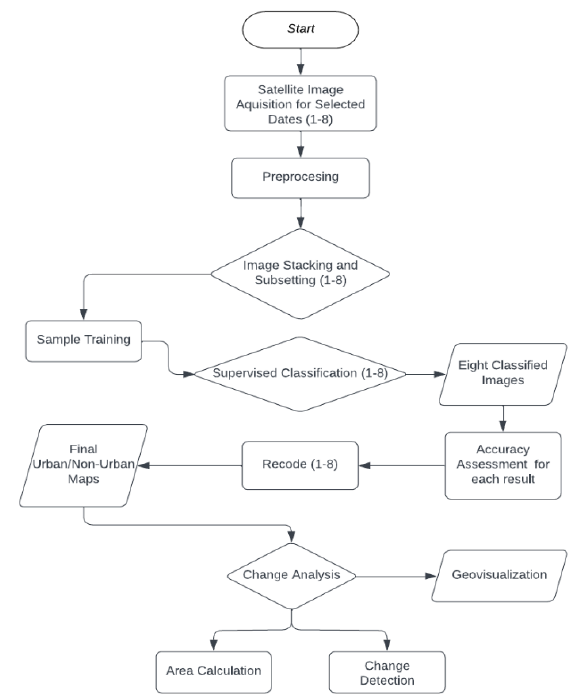
Figure 2. Flowchart showing the methodology of research of the study